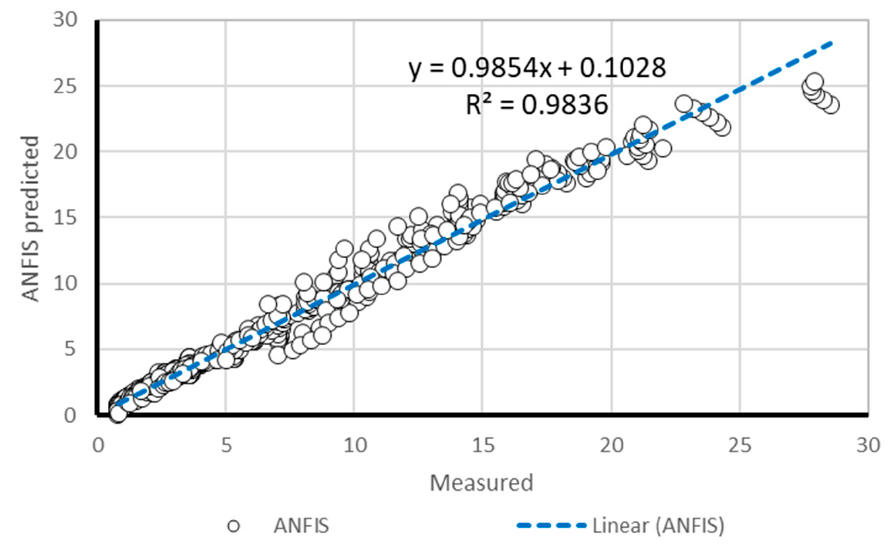
( b ) ANFIS model in predicting factor of safety.